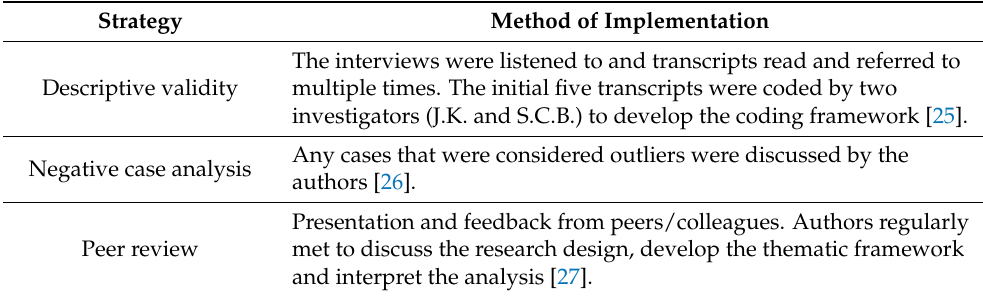
Table 1. Strategies implemented for qualitative rigour and